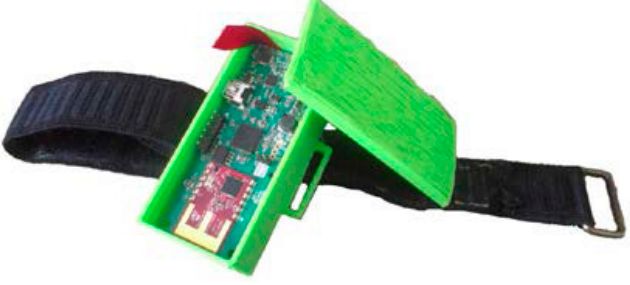
Figure 2. IMU sensor inside its 3D printed case.